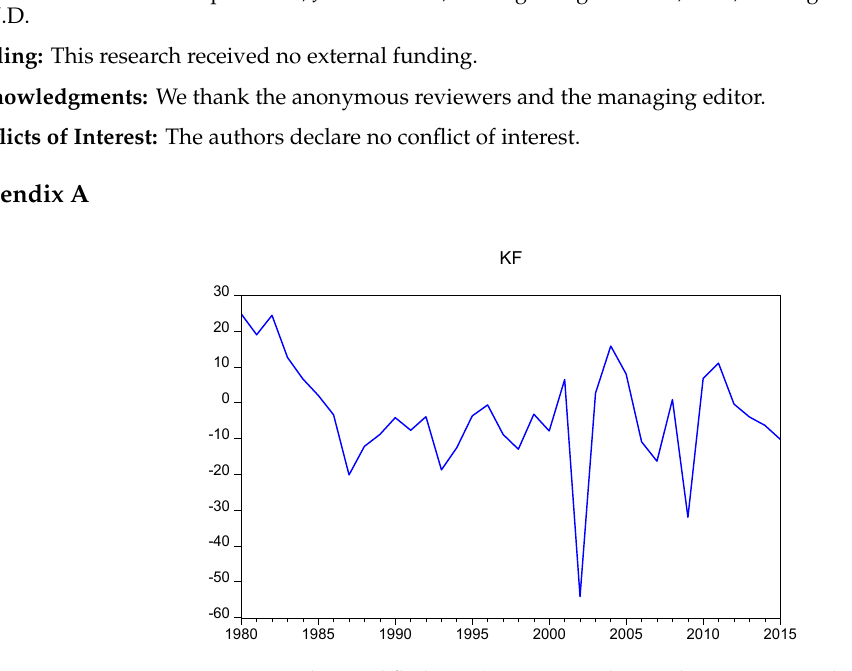
Figure S1. Plots of CUSUM and CUSUM of squares (LNREER and fundamentals). Figure S2. Plots of CUSUM and CUSUM of squares (KF, LNOPENNESS, RESERVES). Figure S3. Plots of CUSUM and CUSUM of squares (KF, OVER, LNOPENNESS, RESERVES). Figure S4. Plots of CUSUM and CUSUM of squares (KF, UNDER, LNOPENNESS, RESERVES). Table S1. List of variables and data sources.